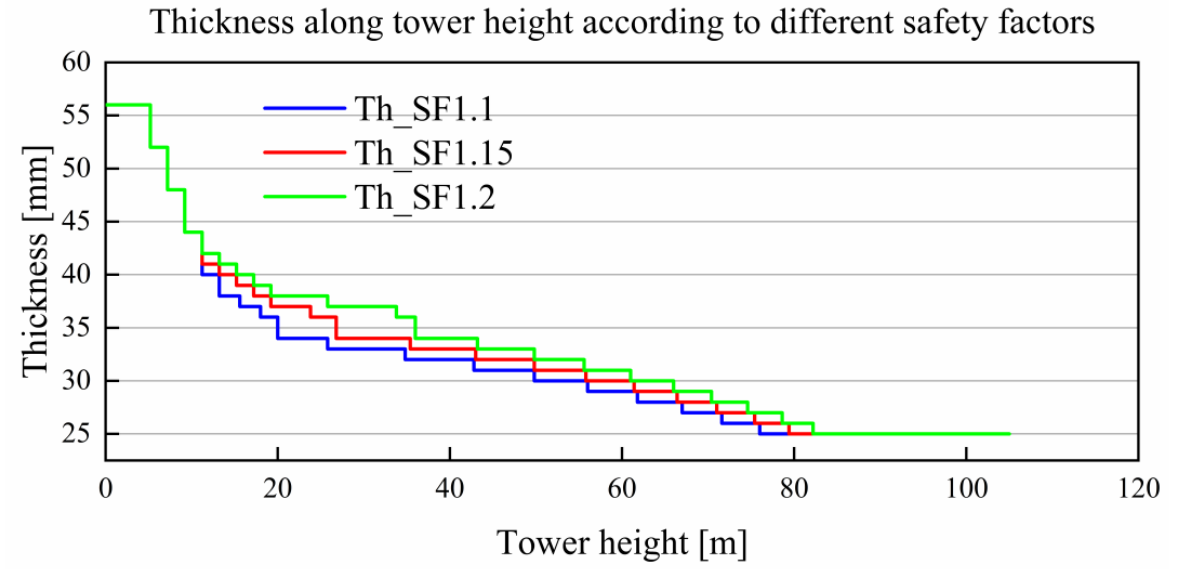
Figure 8. Thickness along tower height according to different safety factors.